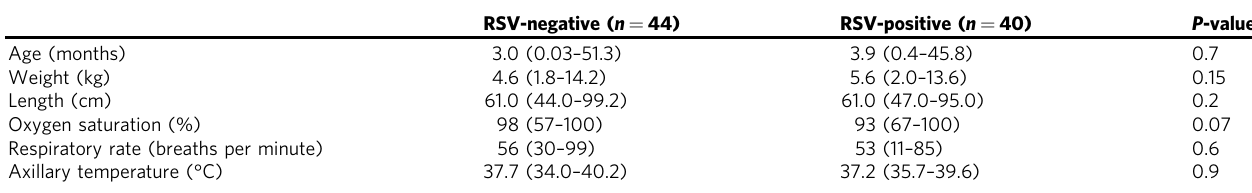
Table 1 Comparison of clinical and anthropometric characteristics of study